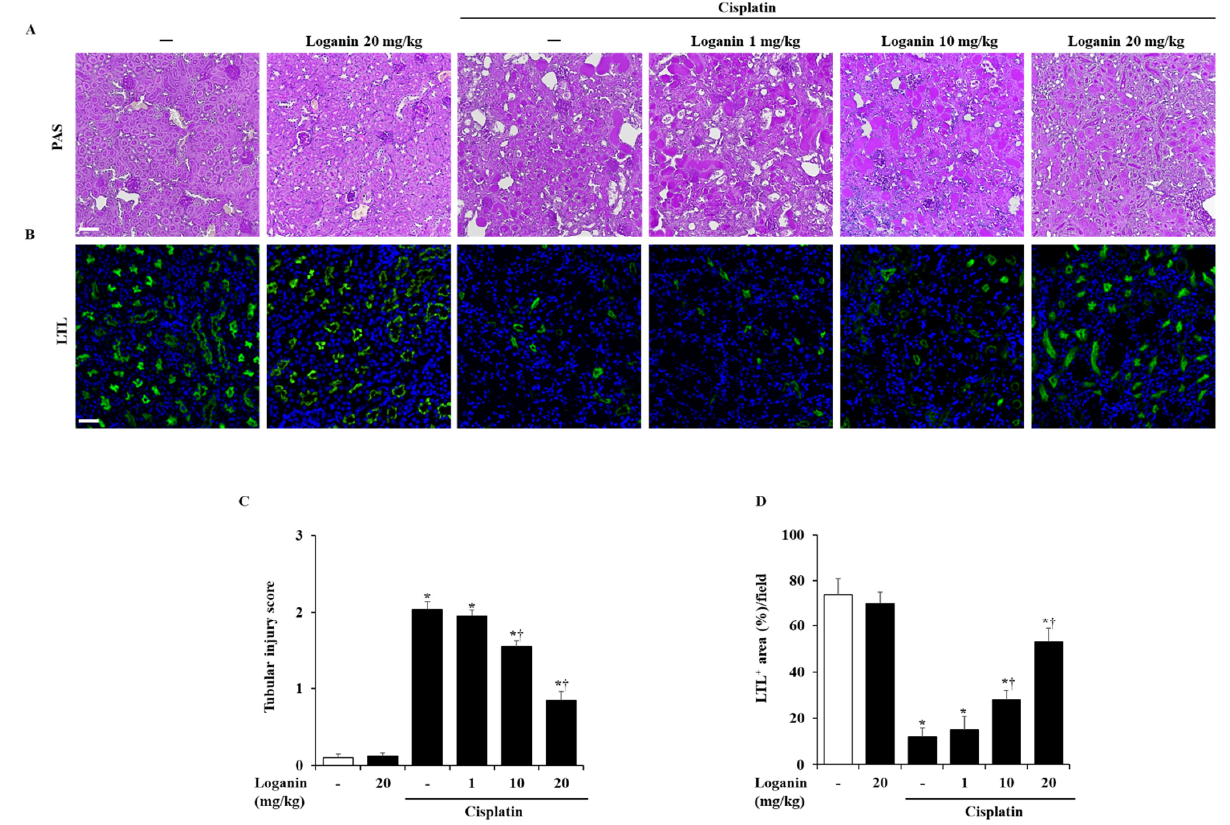
Figure 2. Effect of loganin on renal histologic changes in cisplatin-induced AKI. ( A ) Representative periodic acid–Schiff (PAS)-stained sections of the kidney (200 × magnification). ( B ) Representative lotus tetragonolobus lectin (LTL)-stained sections of the kidney (200 × magnification). ( C ) Histological sections of the kidney were scored from 0 (normal) to 4 (severe) for necrosis of tubule cells. ( D ) LTL-positive areas of the kidney were scored for green fluorescence. Each experiment was repeated 3 times. Data are represented as mean ± SEM ( n = 9). An * indicates p < 0.05 vs. saline-treated control group; † indicates p < 0.05 vs. cisplatin treatment alone. Scale bar = 20 µ